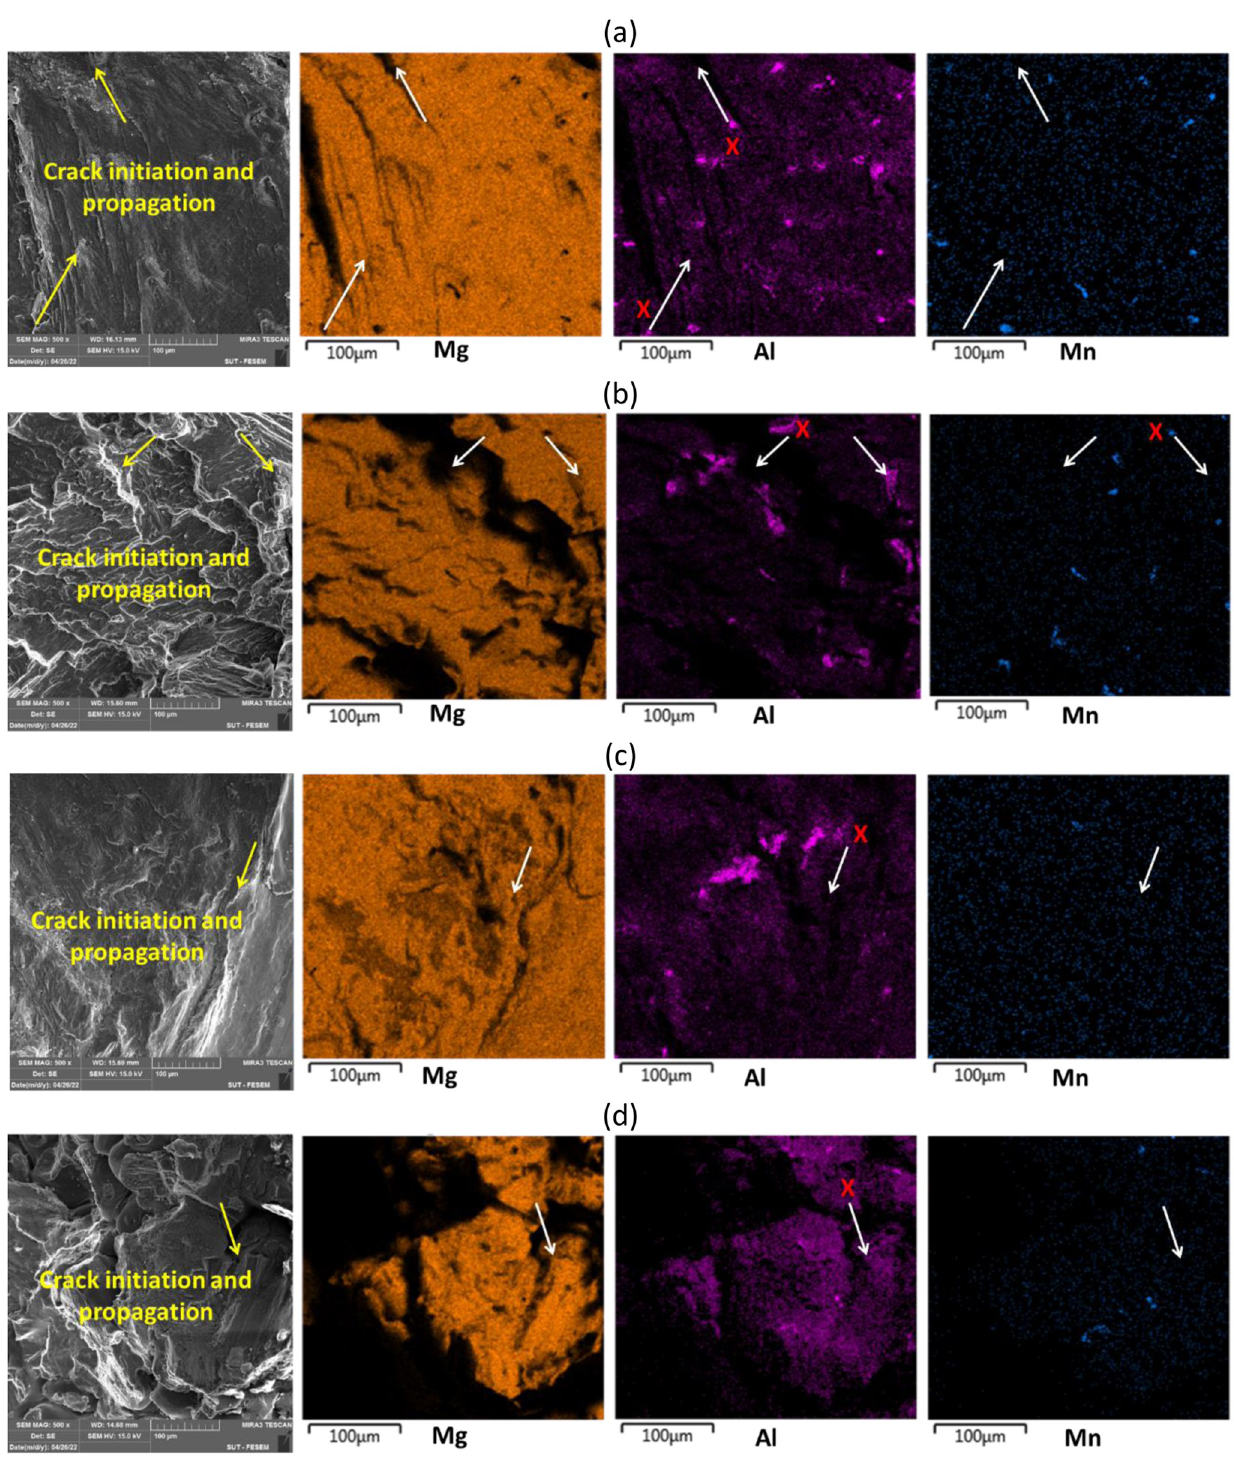
Fig 11. FESEM images with the EDS analysis of sample fracture surfaces for (a) pure fatigue at 80 MPa and (b) 120 MPa of the stress level, (c) fretting fatigue at 80 MPa) and (d) 120 MPa of the stress level (Notes: The arrows start with the crack initiation and their directions show the crack propagation paths. Moreover, the symbol “X” depicts the concentration of the related Al or Mn intermetallic phases in the Mg matrix near the region of the crack initiation).